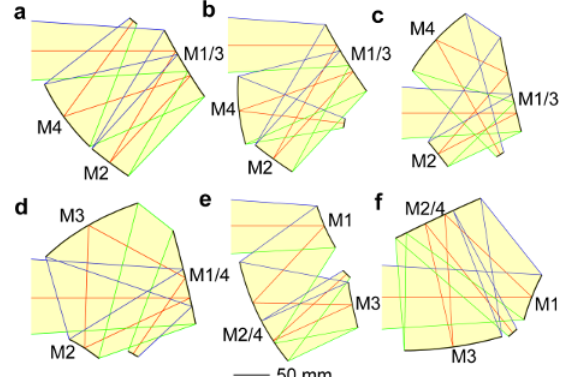
Fig. 4. "First time right" unlocks a new class of three-mirror, four-reflection systems with three different joint mirror